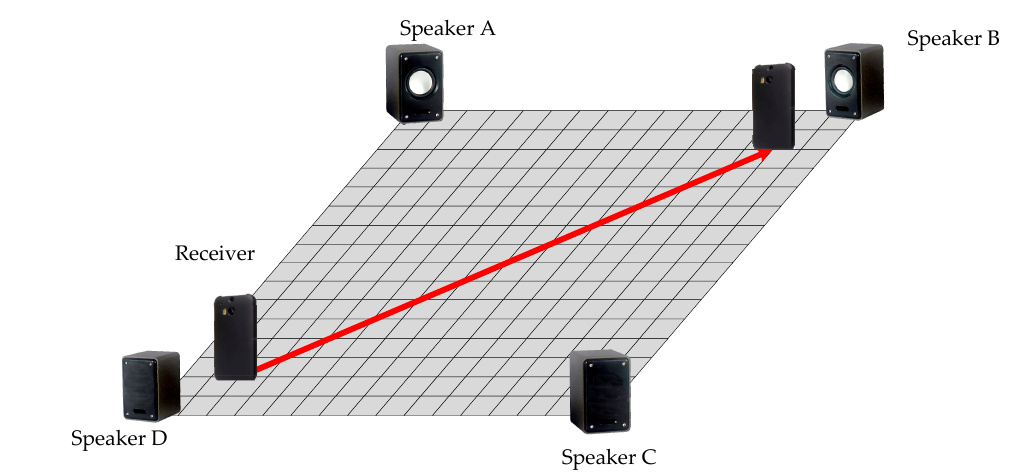
Figure 8. The setting of second experiment.